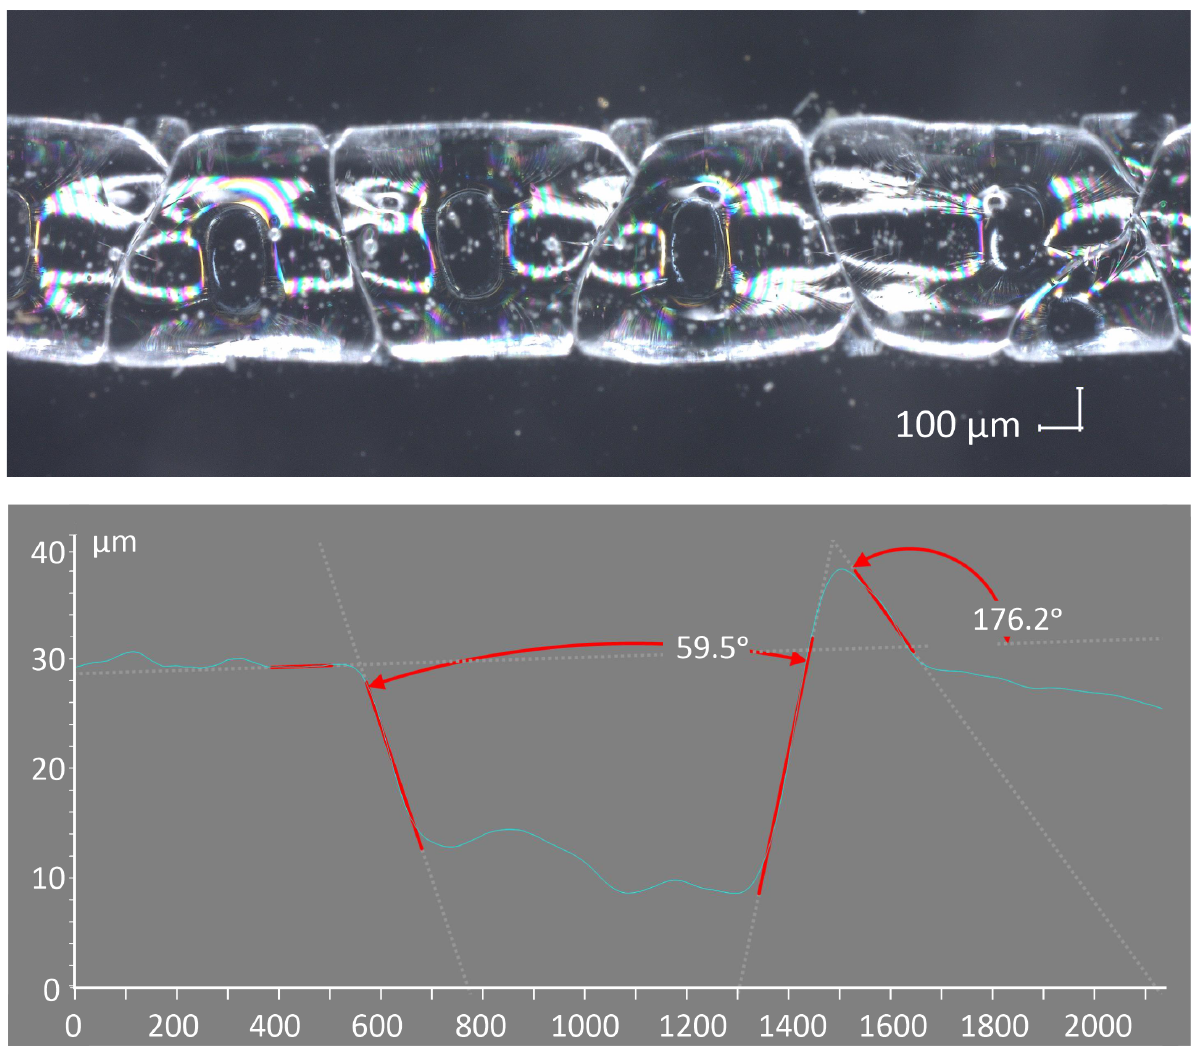
Figure 7. Groove before mechanical removal of cracked deposit. ( Top ): Microscope view of groove. ( Bottom ): Cross-sectional